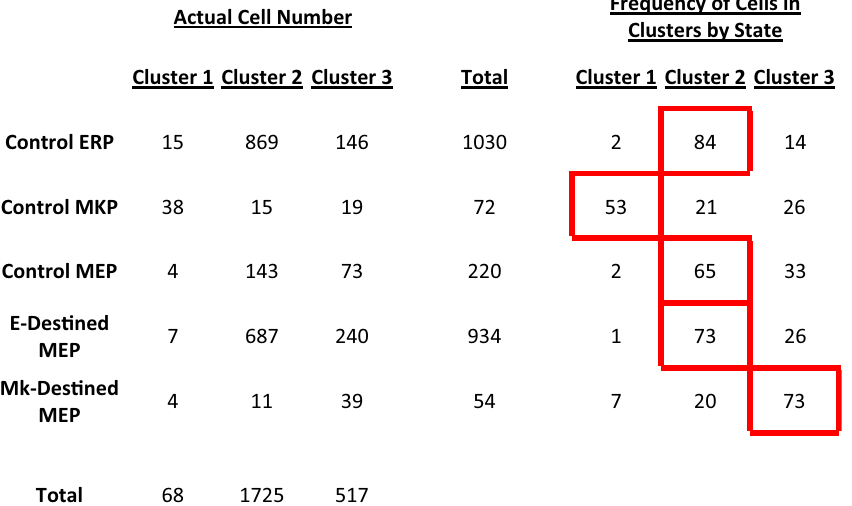
Table 1. Frequency of cell states located within designated cluster. Progenitors were categorized by cell state and the number of cells per state were counted according to the PCA clusters. Actual cell numbers are on the left, and percentages are on the right. The predominant cluster for each cell state is outlined in